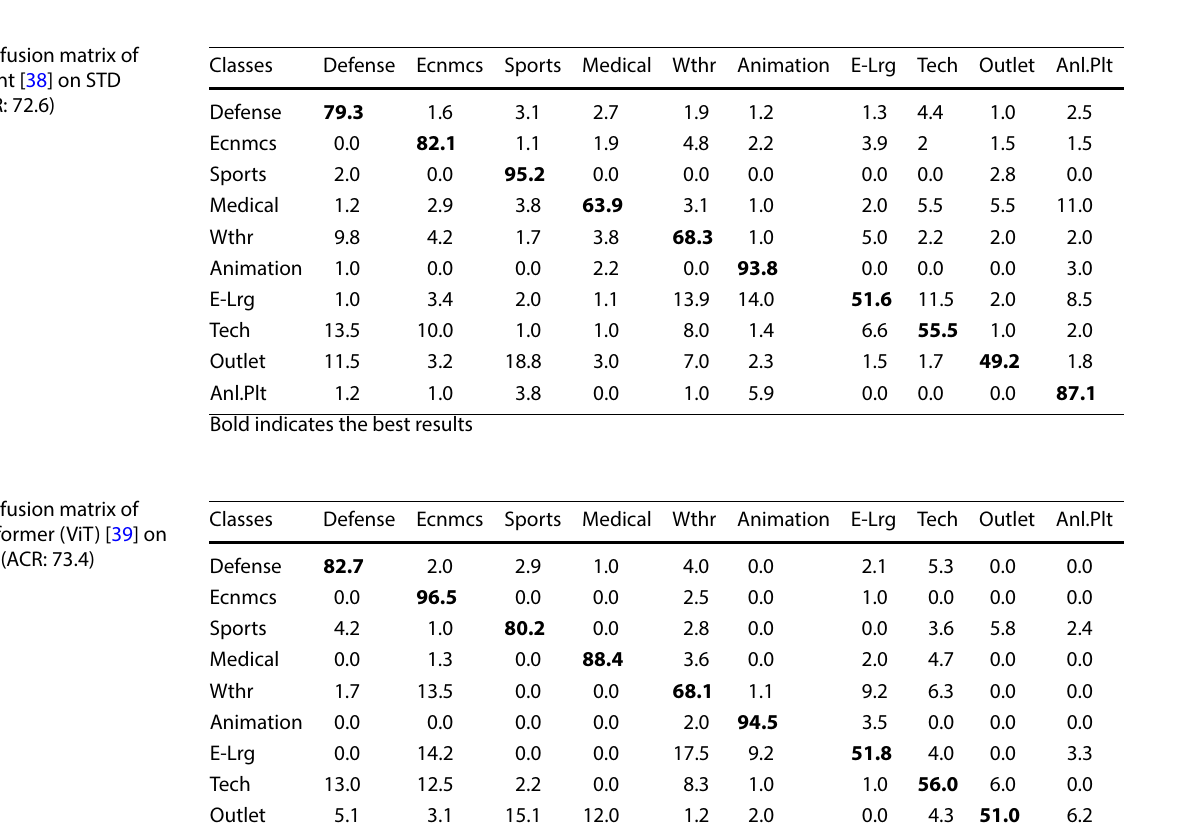
Bold indicates the best